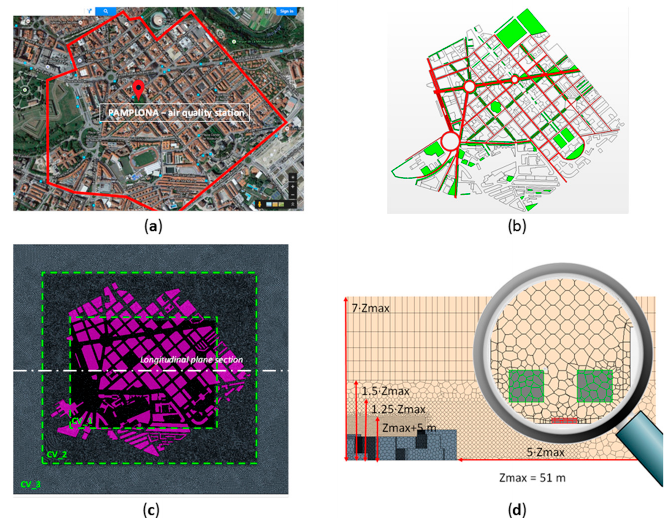
Figure 1. ( a ) II Ensanche neighbourhood of Pamplona (Google Maps ® satellite image [33]), with indication of the modelled domain in red; ( b ) Computational Fluid Dynamic (CFD) 3D model of buildings, trees (green), and traffic emissions (red); ( c ) CFD mesh model; ( d ) Zoom at the longitudinal plane section of CFD mesh: typical sizes as function of the highest building in the domain,